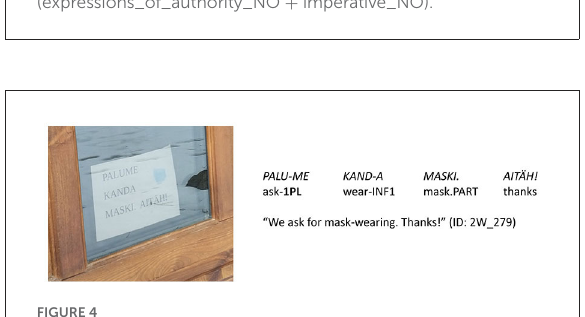
FIGURE4 Type of person usage “1st person only” (expressions_of_authority_NO + imperative_NO).